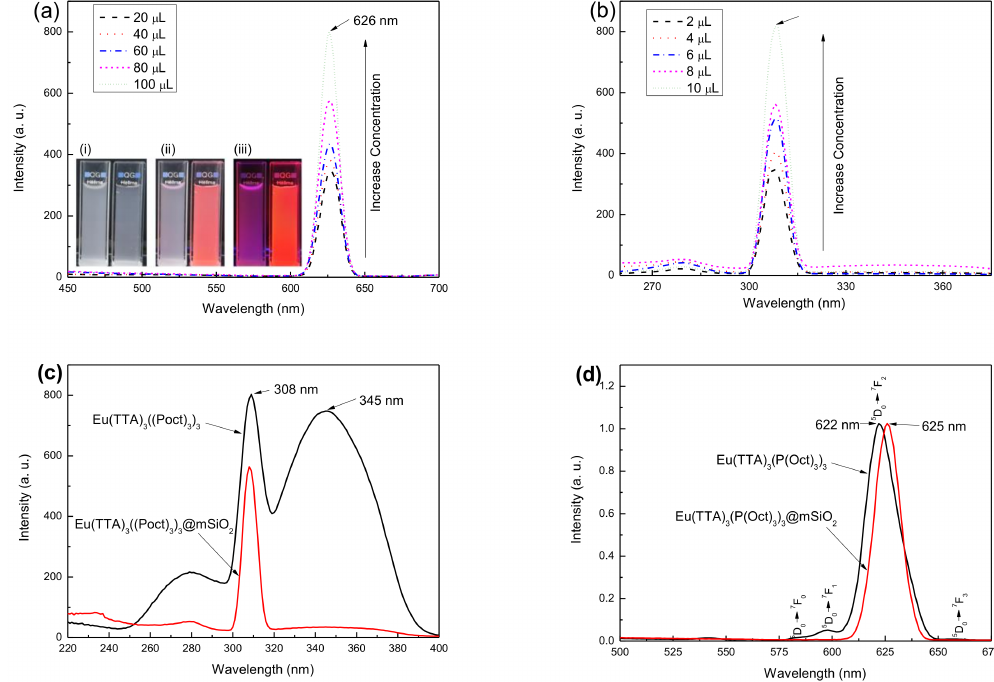
Figure 5. Concentration dependent ( a ) emission ( λ ex = 308 nm) and ( b ) excitation ( λ em = 625 nm) spectra for the 5 D 0 → 7 F j (Eu 3+ , J = 0–4) transition of Eu(TTA) 3 (P(Oct) 3 ) 3 @mSiO 2 . ( c ) excitation ( λ em = 625 nm) spectra for the 5 D 0 → 7 F j transition of Eu(TTA) 3 (P(Oct) 3 ) 3 and Eu(TTA) 3 (P(Oct) 3 ) 3 @mSiO 2 . ( d ) emission ( λ ex = 308 nm) spectra for the 5 D 0 → 7 F j (Eu 3+ , J = 0–4) transition of Eu(TTA) 3 (P(Oct) 3 ) 3 and Eu(TTA) 3 (P(Oct) 3 ) 3 @mSiO 2 . Inserted images in ( a ) are mSiO 2 (left) and Eu(TTA) 3 (P(Oct) 3 ) 3 @mSiO 2 (right) exposed under (i) room light, (ii) room + UV light and (iii) UV